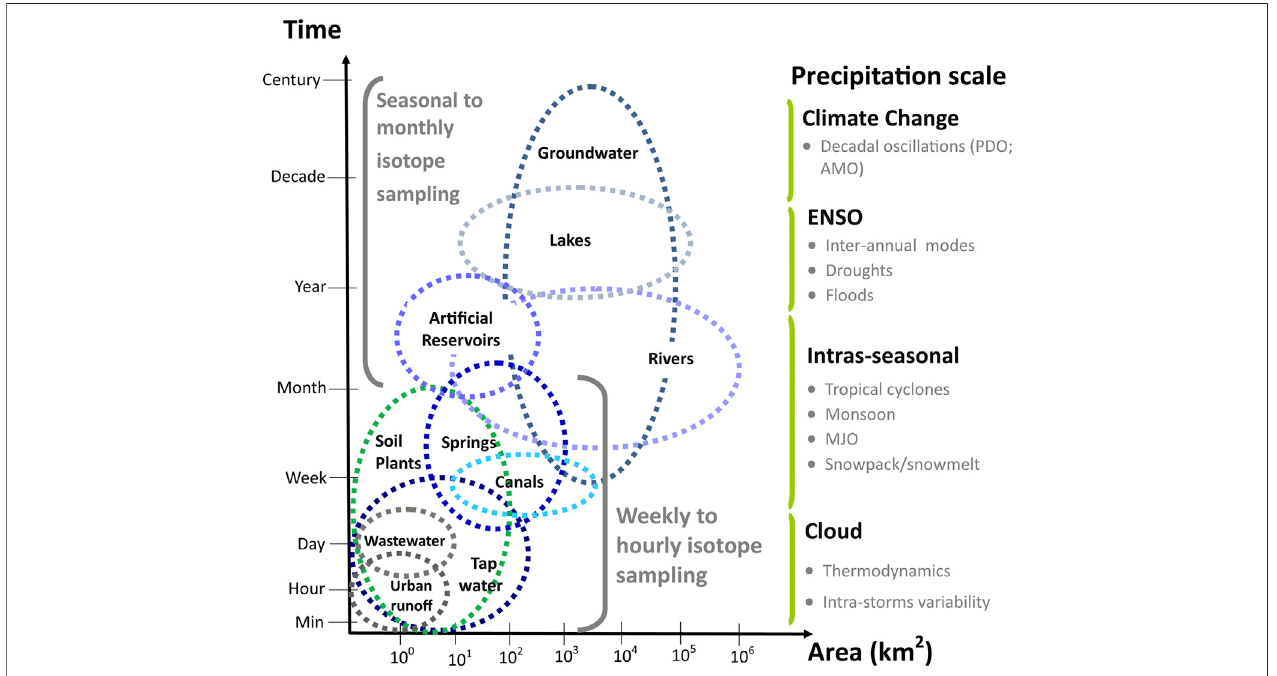
FIGURE 15 | Conceptual diagram of the spatiotemporal sampling dilemma. X and Y axes show the potential scales of water cycle components and arti fi cial features and water residence times, respectively. Right panel includes different features of precipitation regimes from decadal climate variability to cloud thermodynamics. Dashed ovals denote a potential time/area boundary for each water compartment or feature. Gray parentheses represent suggested stable isotope sampling frequencies.